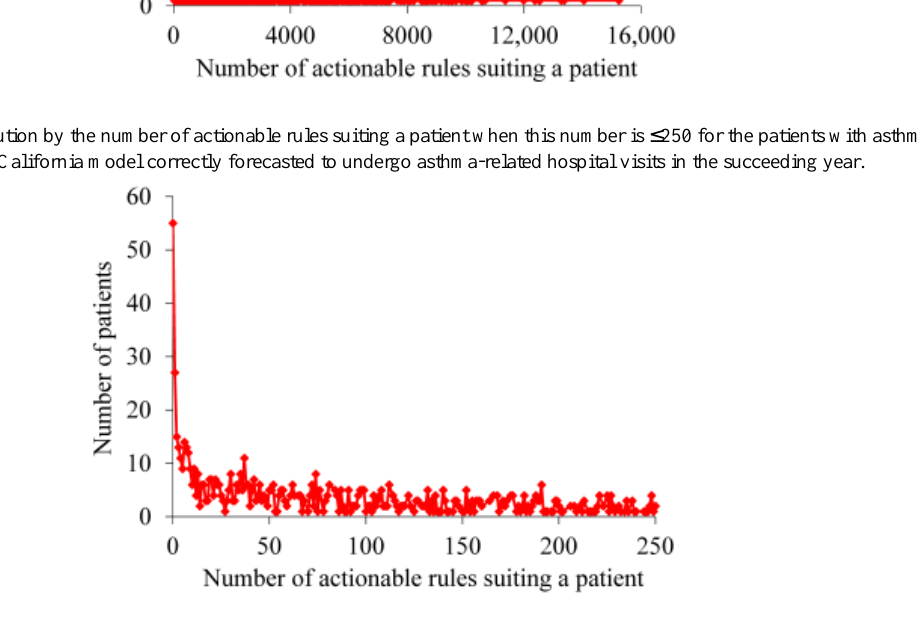
Figure 4. The patient distribution by the number of different actionable items included in all the rules suiting a patient for the patients with asthma whom our Kaiser Permanente Southern California model correctly forecasted to undergo asthma-related hospital visits in the succeeding